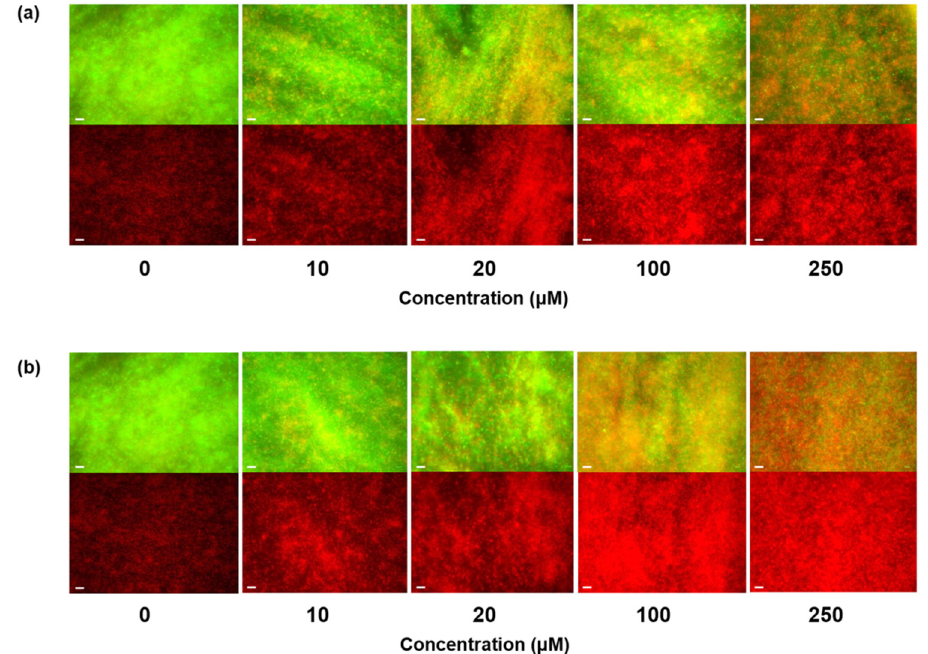
Figure 4. Fluorescence microscopy images using LIVE/DEAD bacterial viability assay, showing the inhibitory effect of ( a ) KCM12 and ( b ) KCM21 on biofilms of Pst DC3000. Scale bar represents 20 µm.